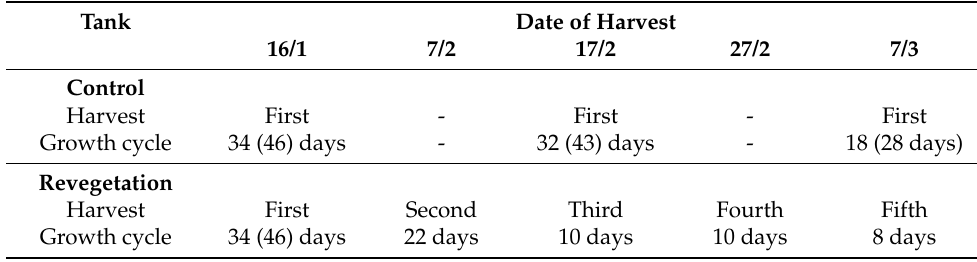
Table 1. Dates of harvest and days in the floating systems of rocket and spinach baby leaves cultivated in control or revegetation tanks. Days from sowing to first harvest are shown in